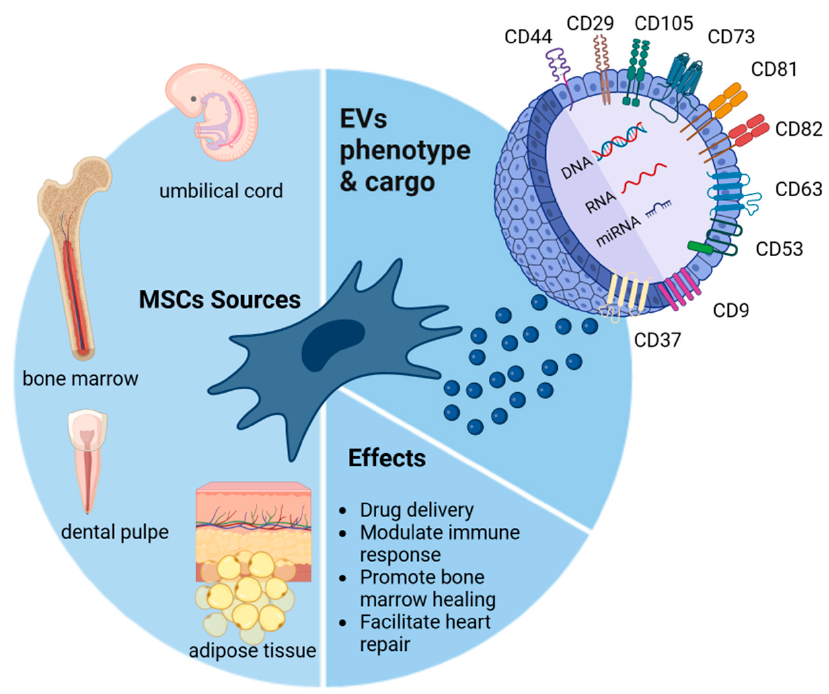
Figure 1. Essential mesenchymal stromal cell (MSC) sources and their extracellular vesicle (EV) phenotypes, cargos (CD29, CD44, CD73, CD105, CD81, CD82, CD63, CD53, CD9, CD37, DNA, RNA, and miRNA), and summarized effects.